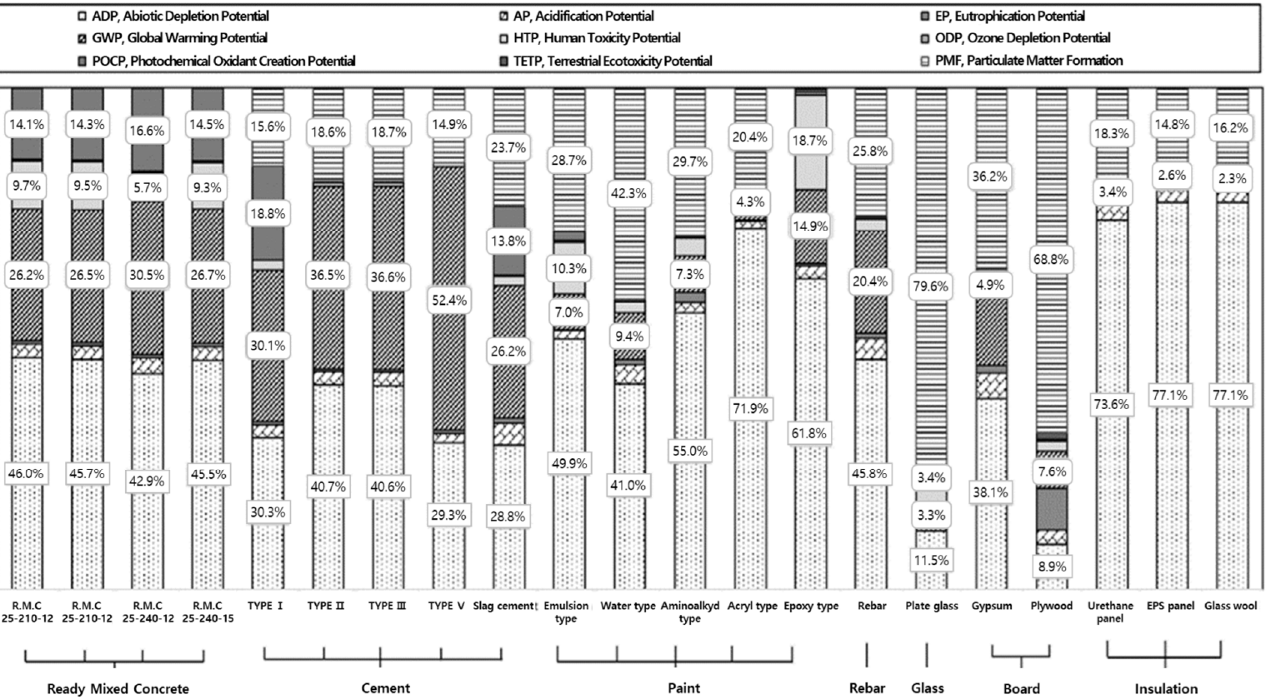
Figure 3. Major environmental impact categories of construction materials. Accordingly, GWP, ADP, and EP tended to increase in ascending order for Portland cement types 3 (rapid hardening), 5 (sulfate resistant), 1 (ordinary Portland cement (OPC)), and 2 (moderate heat cement). Among the calcium-silicate compounds that constitute ce- ment clinkers, the content of belite (C 2 S, 2CaO·SiO 2 ) generally increased, in ascending order